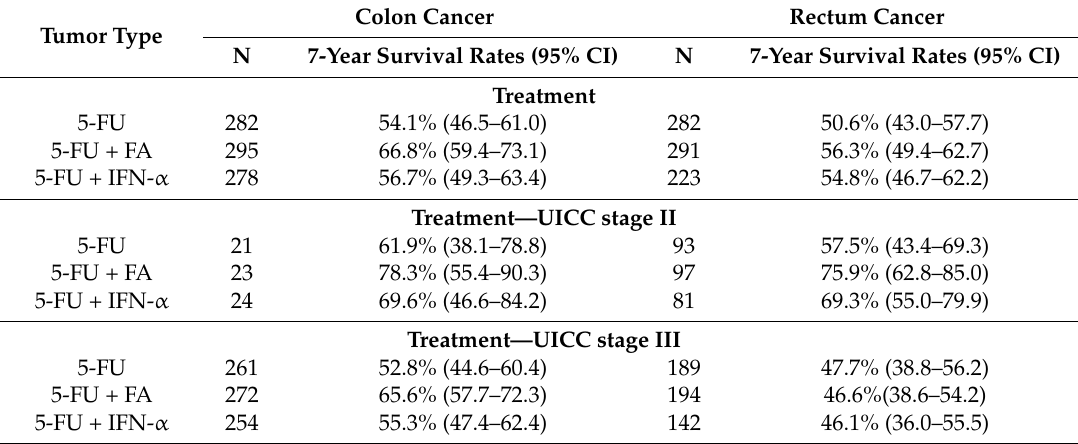
Table 5. Comparison of the seven-year survival rates after adjuvant chemotherapy of CC (FOGT-1) [1] and radiochemotherapy for RC (FOGT-2) [2] (modified according to Kornmann et al. 2013